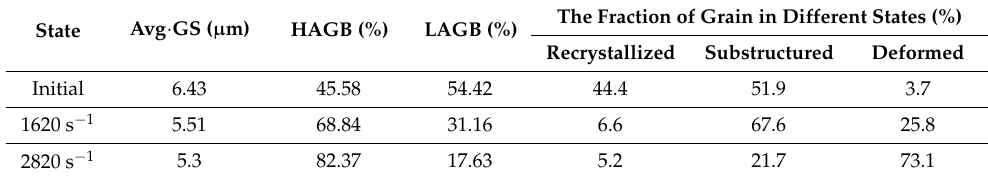
Table 4. Microstructure parameters of the Ti-6Al-1Mo-2Zr-0.55Fe-0.1B alloy in the initial and de- formed states.